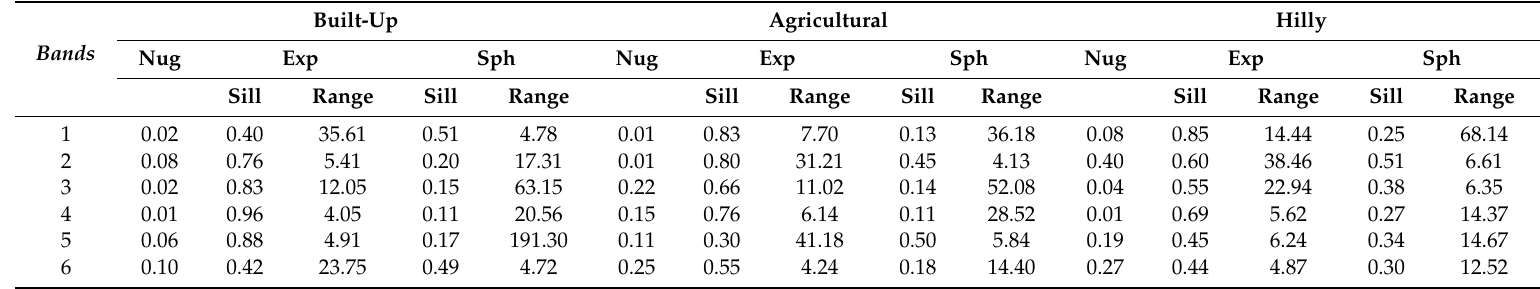
Table 2. Variogram model parameters (nug: nugget, exp: exponential, sph: spherical; units for ranges are number of pixels) for ICA- and normal-transformed image ∼ Z (cid:48)(cid:48) bands ( Z (cid:48)(cid:48) ). 6 1